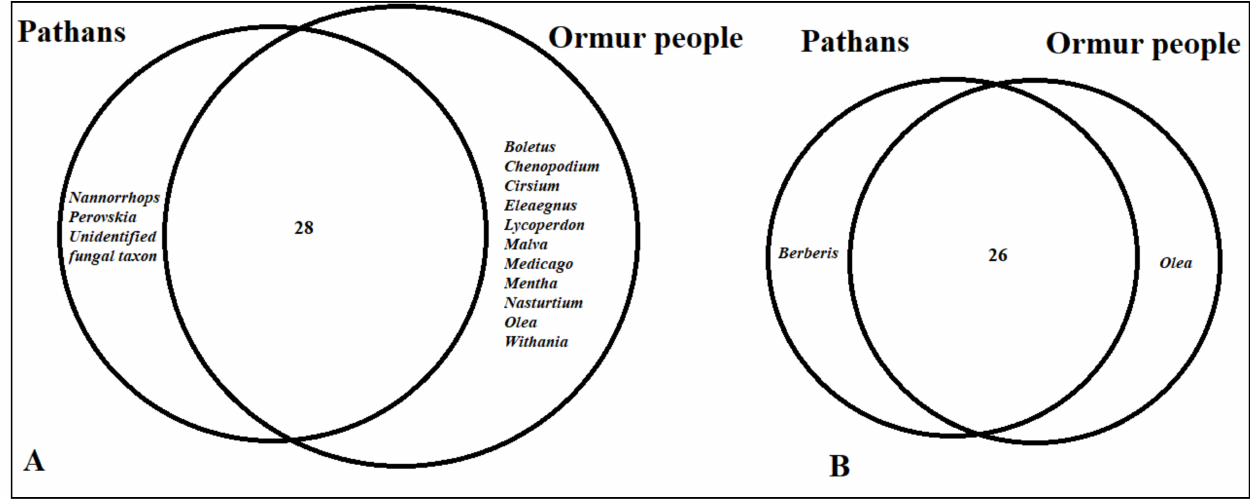
Figure 4. Venn diagram showing overlap of ( A ) all reported wild plant and fungal taxa ( B ) the most frequently reported wild plant and fungal taxa (quoted by more than 50% of informants) among the studied